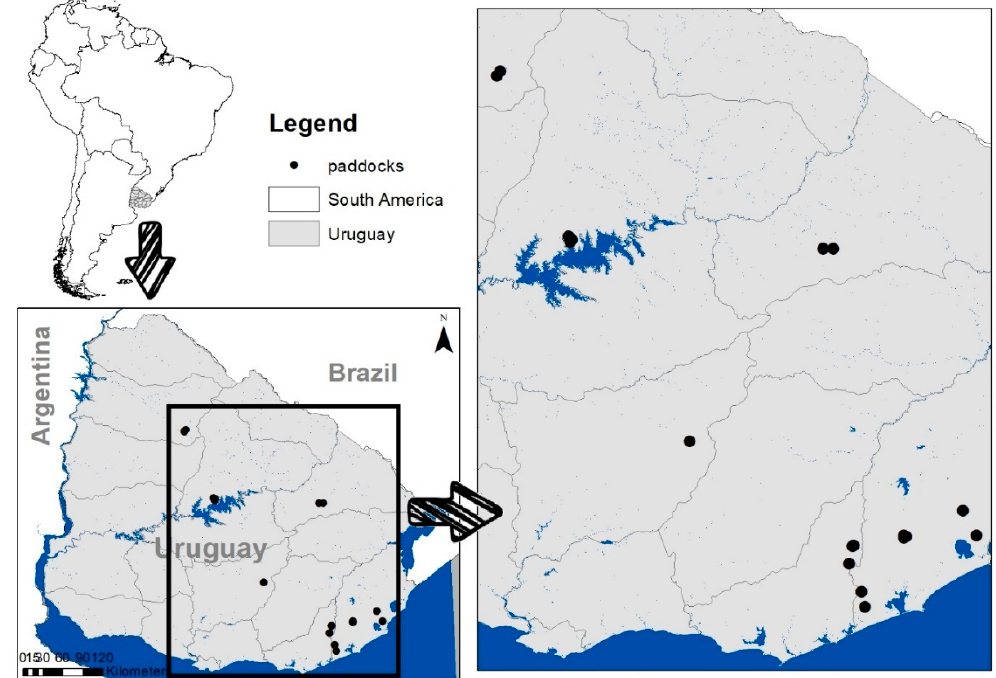
Figure 1. South America map highlighting Uruguay (up-left corner) and paddock´ location in Uruguay (bottom left corner and right).